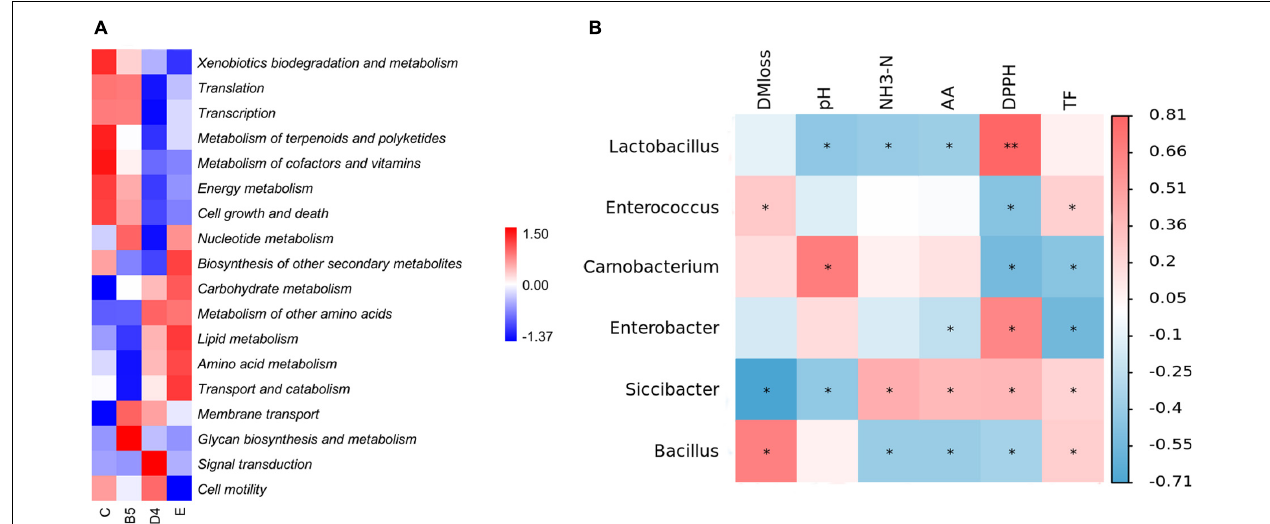
FIGURE 6 | Heatmap of 16S rRNA gene predicted functional profiles (A) and Pearson’s correlation analysis of the bacterial community composition and ensiling parameters (B) in trial 3 . * P < 0.05; ** P <